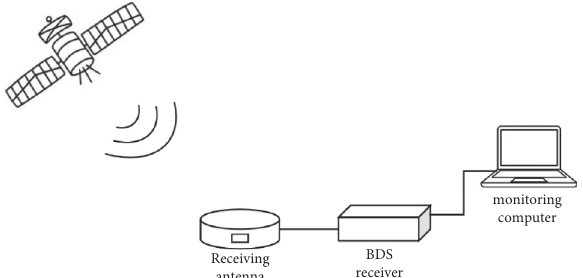
Figure 4: Actual satellite experiment scenario.